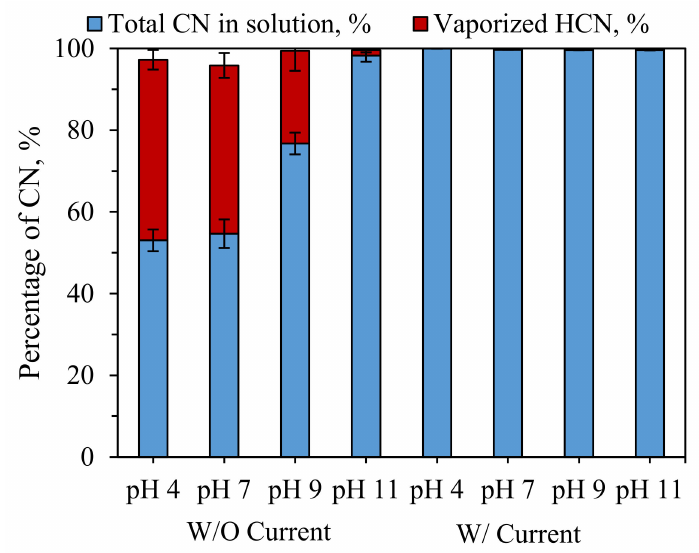
Figure 4. Mass balance of CN − in the system as a function of various pH values with and without current applied. Initial CN − concentration of 10 mg/L. Current intensity of 1 A. N 2 purging and mechanical mixing. Reaction time of 30